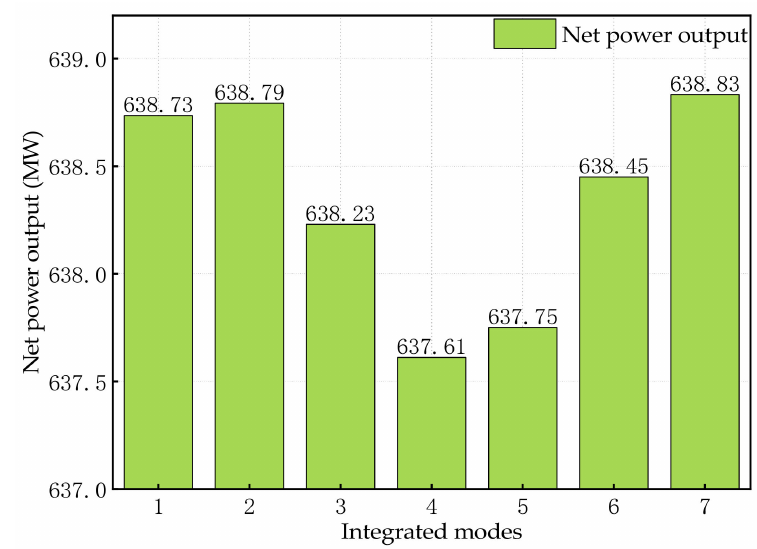
Figure 7. The net power output result of different integrated